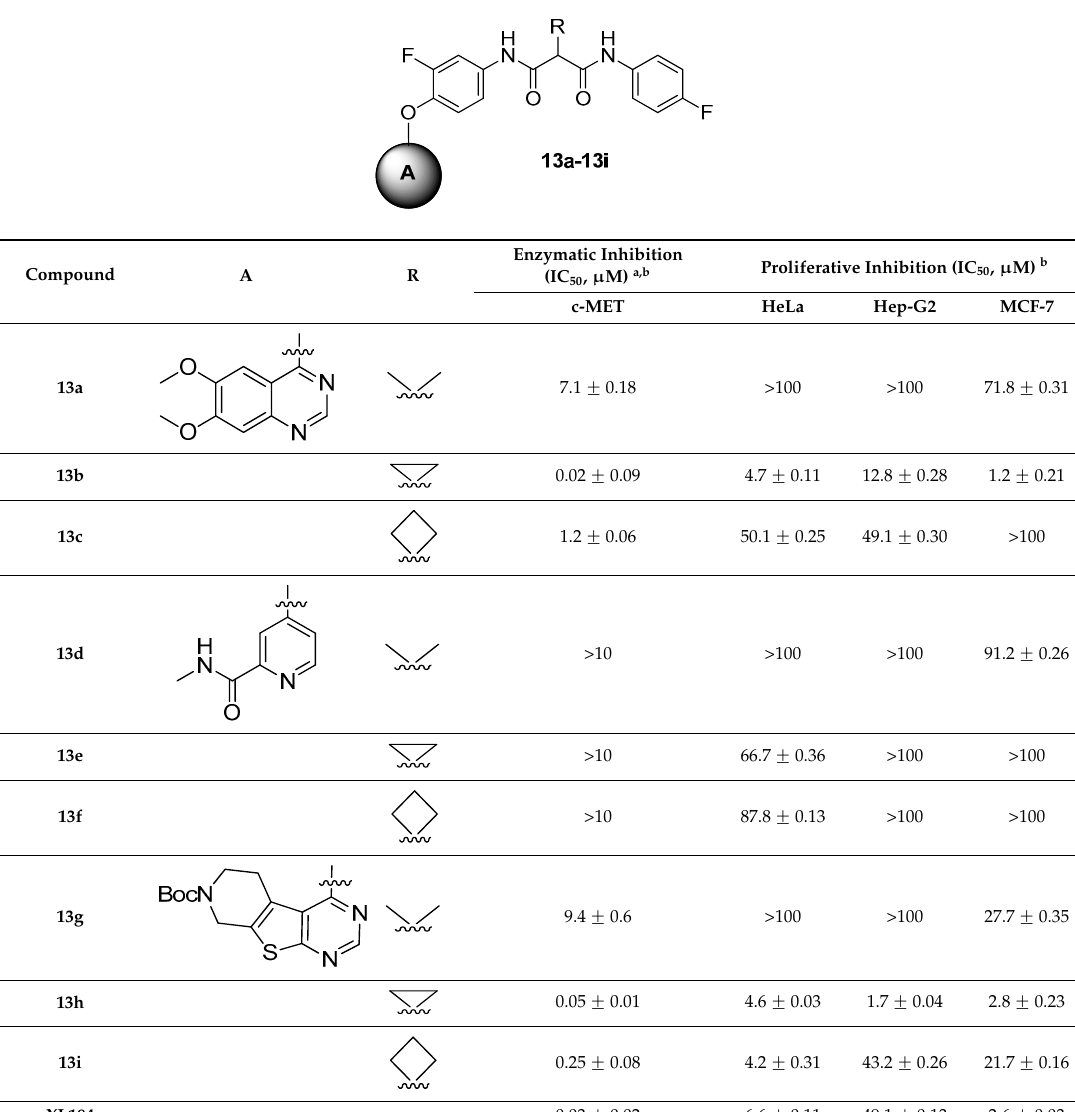
Table 3. Enzymatic and cellular results for compound 13a – c.